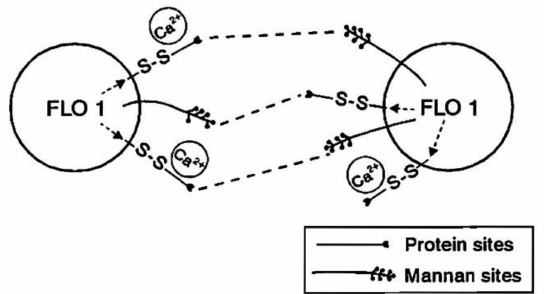
Figure 3. Lectin theory of flocculation. Protein lectins on the yeast cell surface interact with either mannose-containing and/or glucose-containing carbohydrate determinants on the cell walls of adjacent cells only in the presence of calcium